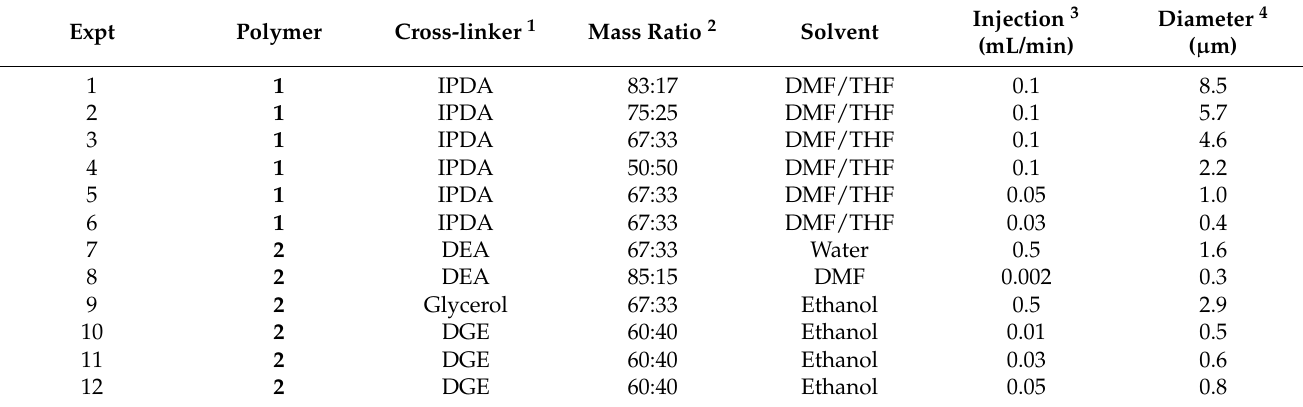
Table 1. Electrospinning conditions to form various PNBE-based thermoset